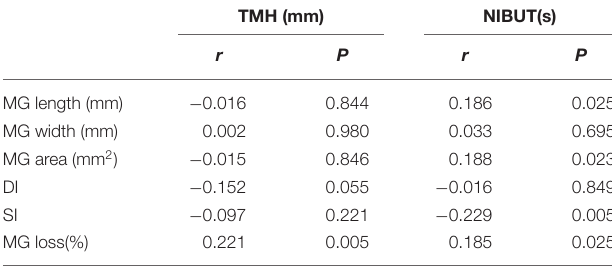
0.003, P < 0.001, P = 0.001, and P < 0.001, respectively) and TABLE 2 | Correlation coefficients of clinical tests and meibomian gland (MG)